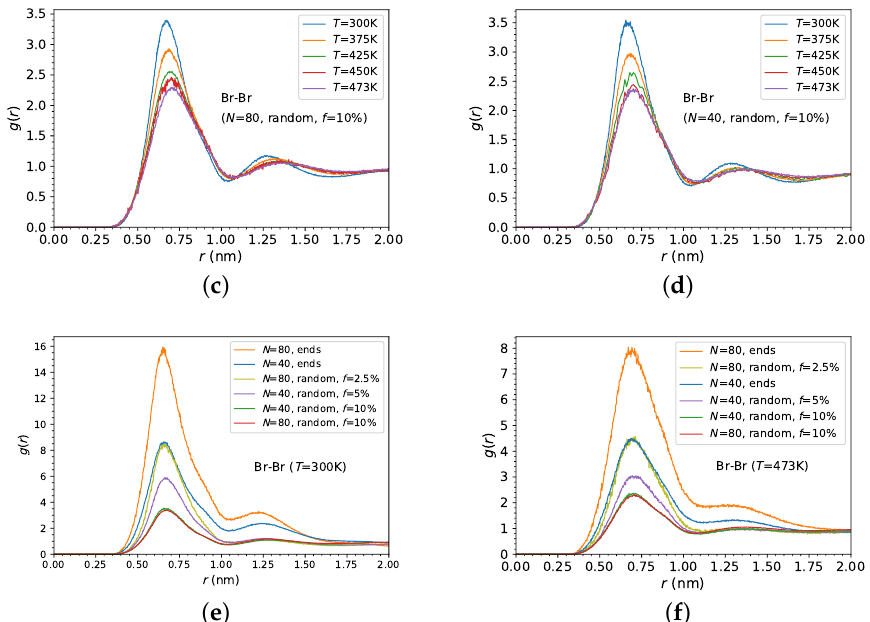
Figure 4. Br − -Br − radial distribution functions g Br,Br ( r ) of ( a , b ) end-functionalized PDMS chains, ( c , d ) randomly grafted f = 10% functionalized PDMS chains, at different temperatures. ( a , c ) N = 80 versus ( b , d ) N = 40 and ( e , f ) for various charged monomer fractions f at two different temperatures, ( e ) T = 300 K and ( f ) T = 473